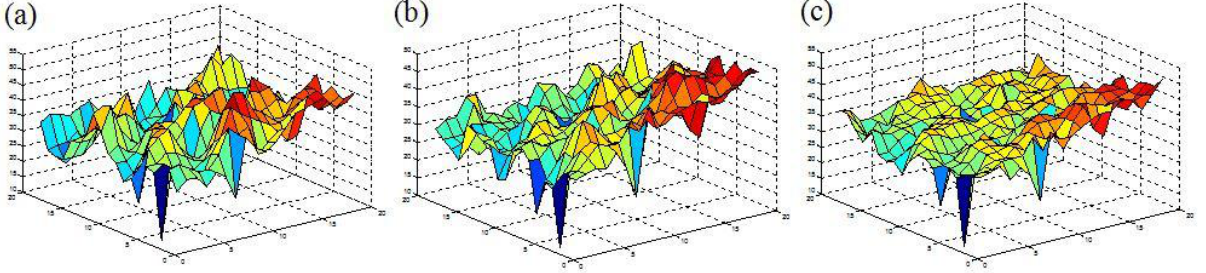
Figure 3. ( a ) Pixel 3D mapping of coarse sandpaper image; ( b ) Pixel 3D mapping of medium sandpaper image; ( c ) Pixel 3D mapping of fine sandpaper